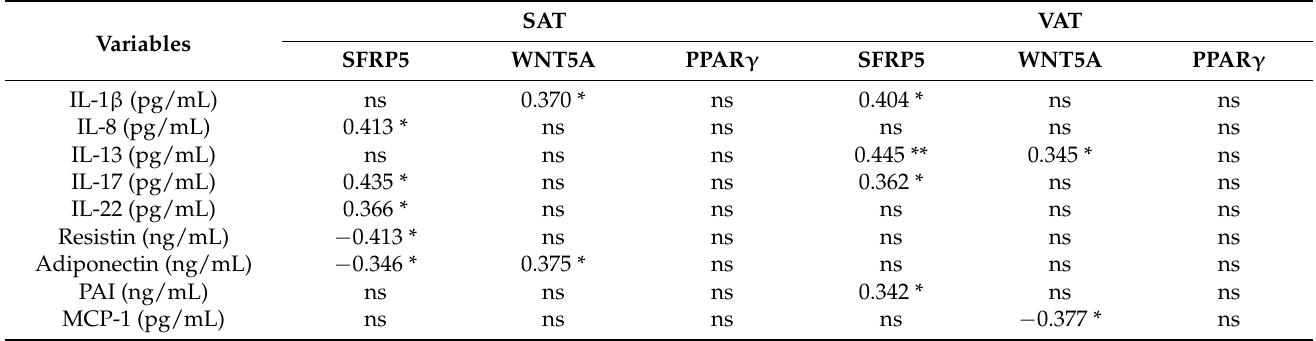
Table 2. Correlations between circulating cytokines and the relative mRNA expression of SFRP5, WNT5A or PPAR γ in SAT and VAT of MO